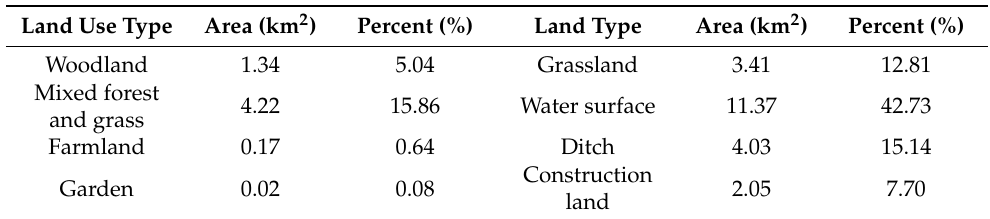
Table 1. Land use status of the Huanghe Island.